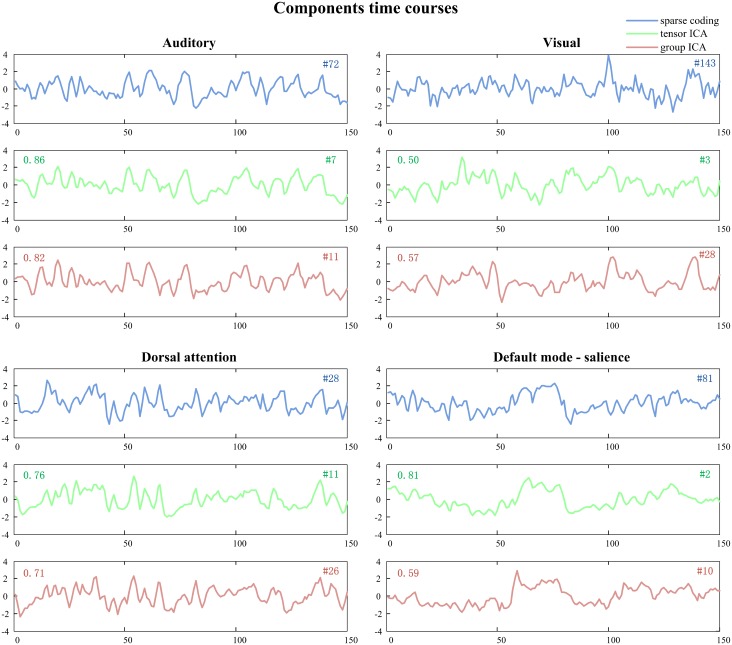
Time courses of representative networks identified by group sparse representation, tensor ICA and spatial concatenation group ICA.Pearson’s correlation between the time courses of group sparse representation and ICA is labeled on the panel of the corresponding ICA method (upper left corner).